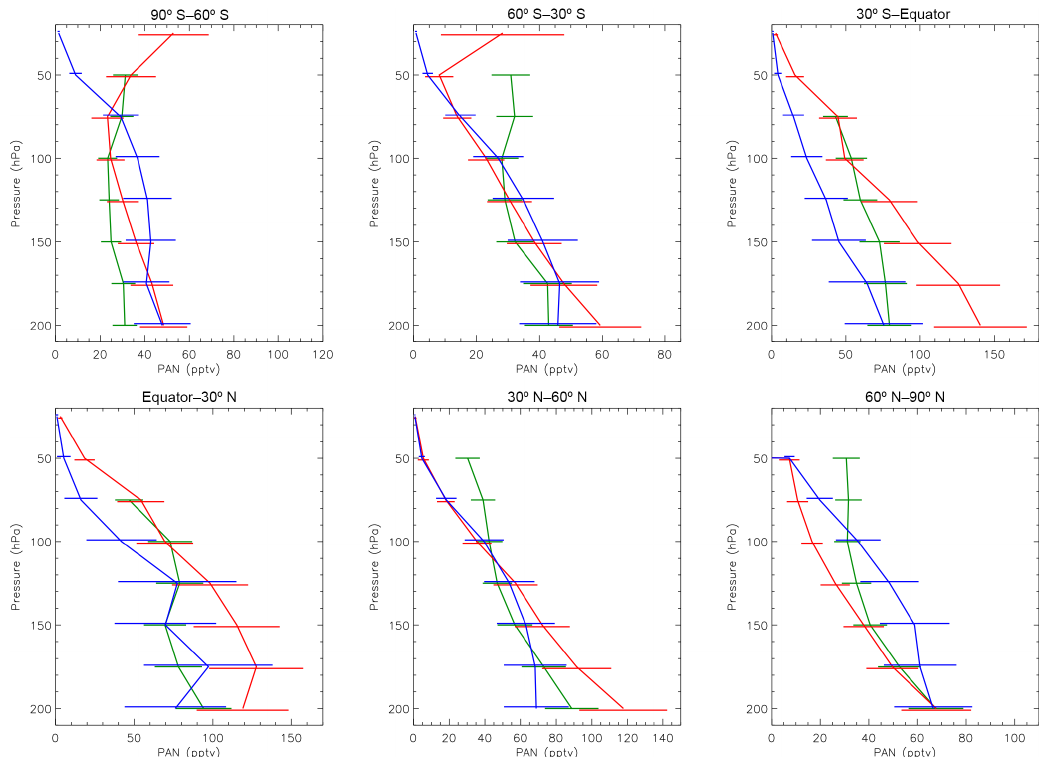
Figure 7. Zonal mean profiles of PAN (pptv) averaged within different latitude bands for 2007–2008 from ACE-FTS (green line), IMK MIPAS (red), and UoL MIPAS (blue). Horizontal lines give the satellite uncertainty ranges. MIPAS retrievals have been co-located with ACE-FTS